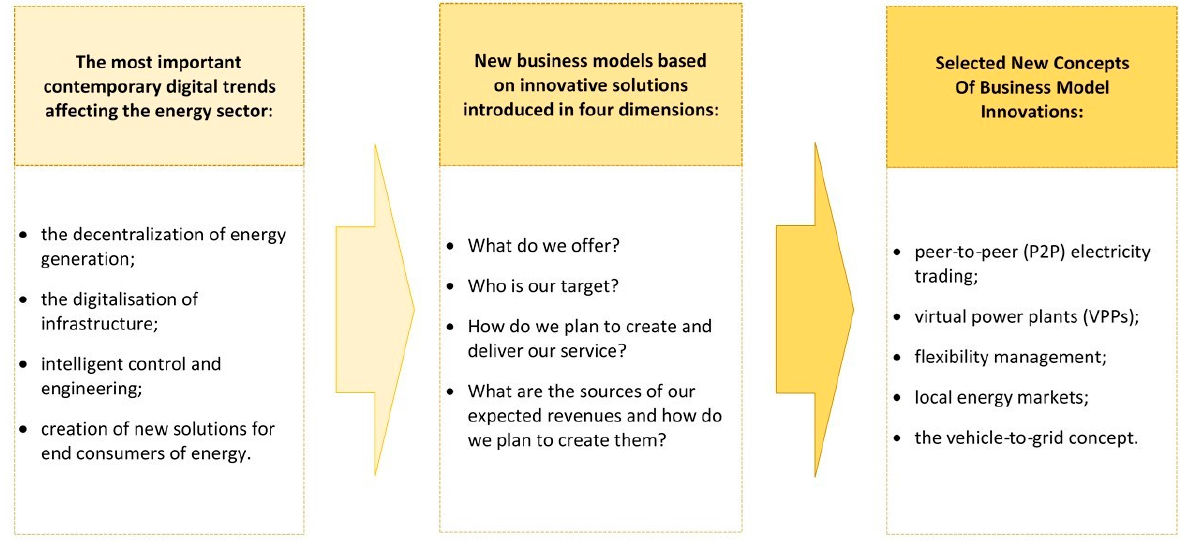
Figure 3. The main digital trends and the most popular business models observed in the energy sector practice in the 21st century [44,45,47–65]. sector practice in the 21st century